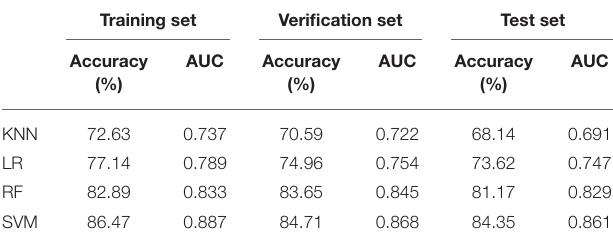
TABLE 4 | The result of different machine learning models in training, verification, and test set. Training set